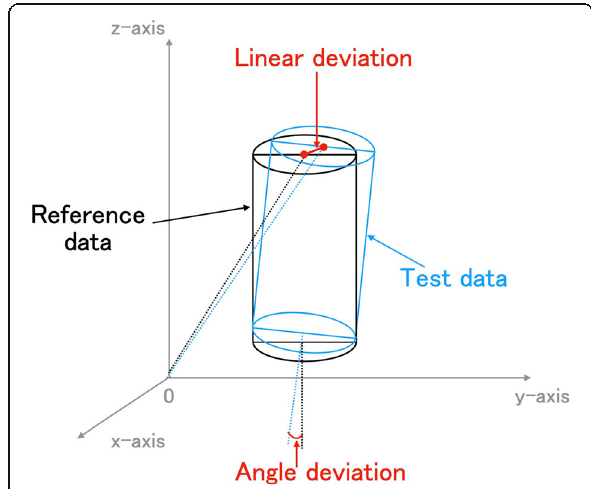
Fig. 2 Schematic image: linear and angle errors using three- dimensional shift of test data from reference data